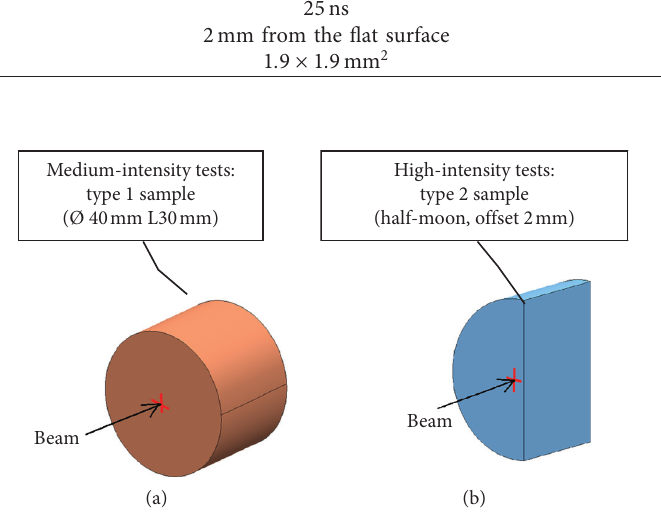
Figure 6: Material specimen shapes for medium intensity type 1 (a) and high intensity type 2 (b)